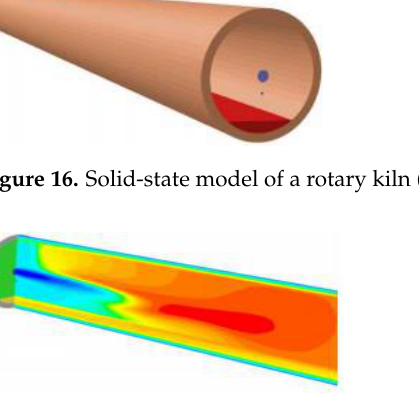
Figure 17. Simulation of the combustion process in a rotary kiln (according to the authors’ data). The results obtained during the simulation are summarized in Table 5. Table 5. Results of physical modeling of the total length of the torch in a rotary kiln/furnace with material recycling.